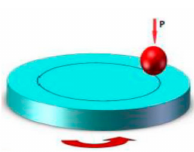
Figure 1. Scheme of the ball-on-disc test [7].